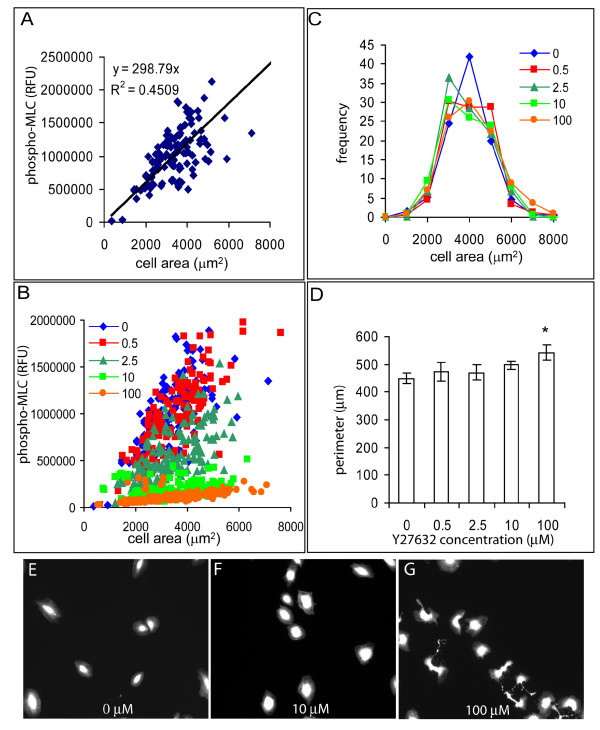
The relationship between cell shape and phospho-MLC in individual cells. A) In the absence of any drug treatment, the area of individual cells was linearly correlated with total diphospho-MLC content per cell. The data shown are from a representative experiment indicating measurements on about 150 cells; RFU (relative fluorescent units) B) Inhibiting ROCK by the addition of the indicated concentrations of Y27632 inhibited phospho-MLC in individual cells while preserving the linear relationship between cell spreading and MLC diphosphorylation. Representative data are shown from experiments involving about 150 cells. C) Treatment with Y27632 did not change the distribution of cell areas within the population as indicated by the similarity of the histograms. D) Inhibiting ROCK increased the perimeter of the cells compared to no drug treatment. These data are average values of cellular perimeters determined from three replicate experiments. Statistically significant difference compared to the perimeter of single cells in the absence of inhibitor (p < 0.05) is indicated by '*'. E) Representative cells in the absence of Y27632, F) in the presence of 10 μM Y27632 and G) 100 μM Y27632. Cells were stained with Tx-Red maleimide as described in Methods.